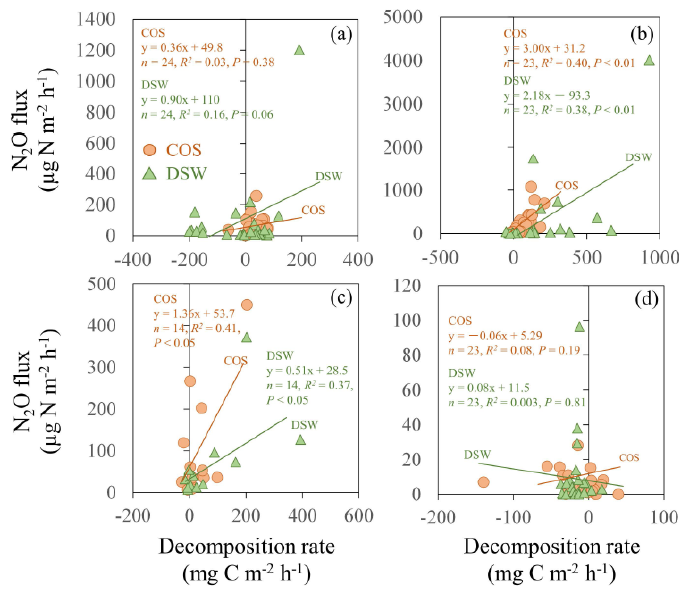
Figure 3. Relationships between soil N 2 O flux and decomposition rate of applied organic materials in the season after basal fertilization ( a ); after supplemental fertilization ( b ); in summer ( c ); and in other seasons ( d ) in 2013 and 2014 in no fertilizer (NF), combined organic and synthetic fertilizer (COS), and distilled silage waste (DSW) treatments in a citrus orchard in southwestern Japan. Table 3. Soil nitrous oxide (N 2 O) emissions (Average ± Standard deviation) for the after basal fertilization (F1), supplemental fertilization (F2), summer (S), other seasons, and annual periods, and the emission factors (EF) of the applied organic materials in the no fertilizer (NF), combined organic and synthetic fertilizer (COS), and distilled silage waste (DSW) treatments in a citrus orchard southwestern Japan.